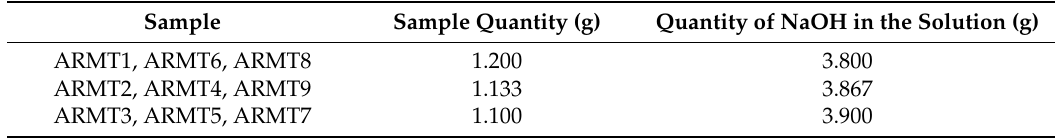
Table 6. Mixture ratios of ARMT samples and NaOH solution used in alkaline-leaching